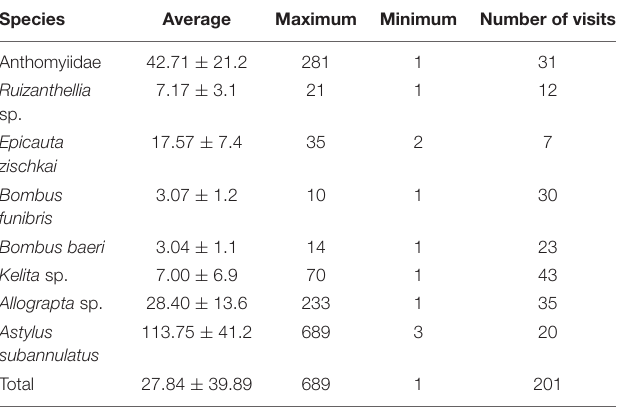
Kelita sp. Allograpta sp. Astylus subannulatus TABLE 5 | Flower visitors recorded in flowers of wild and cultivated potatoes ( F , frequency of visits;%, percentage of visits). Species Wild Cultivated Status Anthomyiidae Ruizanthellia sp. Bombus funibris Bombus baeri